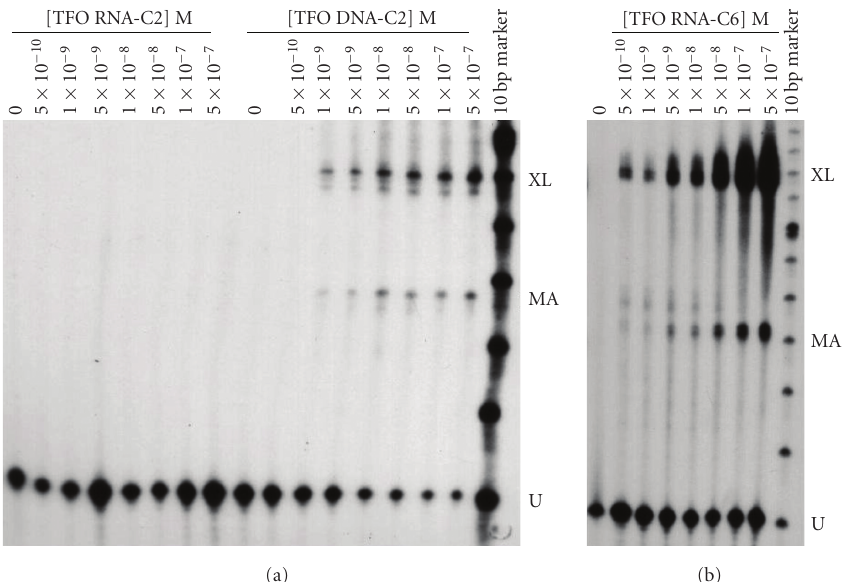
Figure 4: Covalent binding of TFOs to duplex target following UVA. Varying concentrations of (a) TFO DNA-C2 or TFO RNA-C2 or of (b) TFO RNA-C6 were incubated with 5 nM target overnight prior to irradiation with 2J/cm 2 UVA. The products were then analyzed by polyacrylamide gel electrophoresis under denaturing conditions and denoted as unreacted (U), monoadducts (MA), and crosslinks